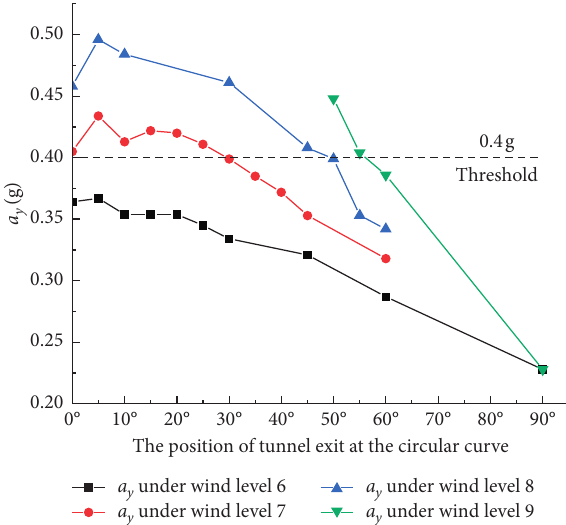
Figure 8: Lateral acceleration of the vehicle at different positions.